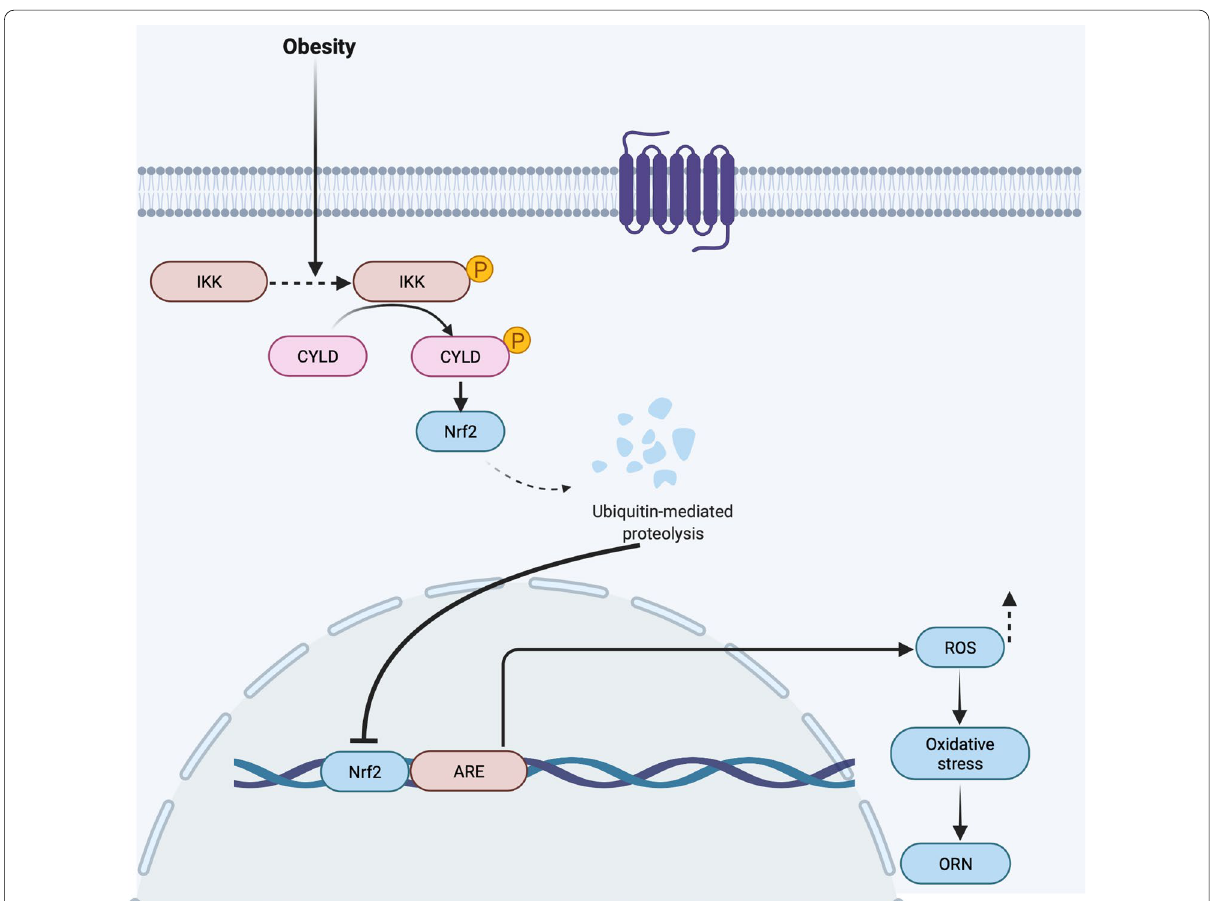
Fig. 8 Schematic representation of the proposed mechanism by which the phosphorylation of IKK and CYLD mediated the activation of the Nrf2/ARE pathway, thereby inducing oxidative stress in human kidney cells. The imbalance between the increase in ROS and/or the decrease in antioxidant activity promotes oxidative stress injury to tissues or cells. Regulation of mitochondrial production of ROS is required for the proper adaptation of renal cells to metabolic stress. The phosphorylation of IKK induced phosphorylation of CYLD results in the inactivation of its deubiquitination activity and is thus unable to prevent the ubiquitination of Nrf2, which promoted the production of ROS and the depolarization